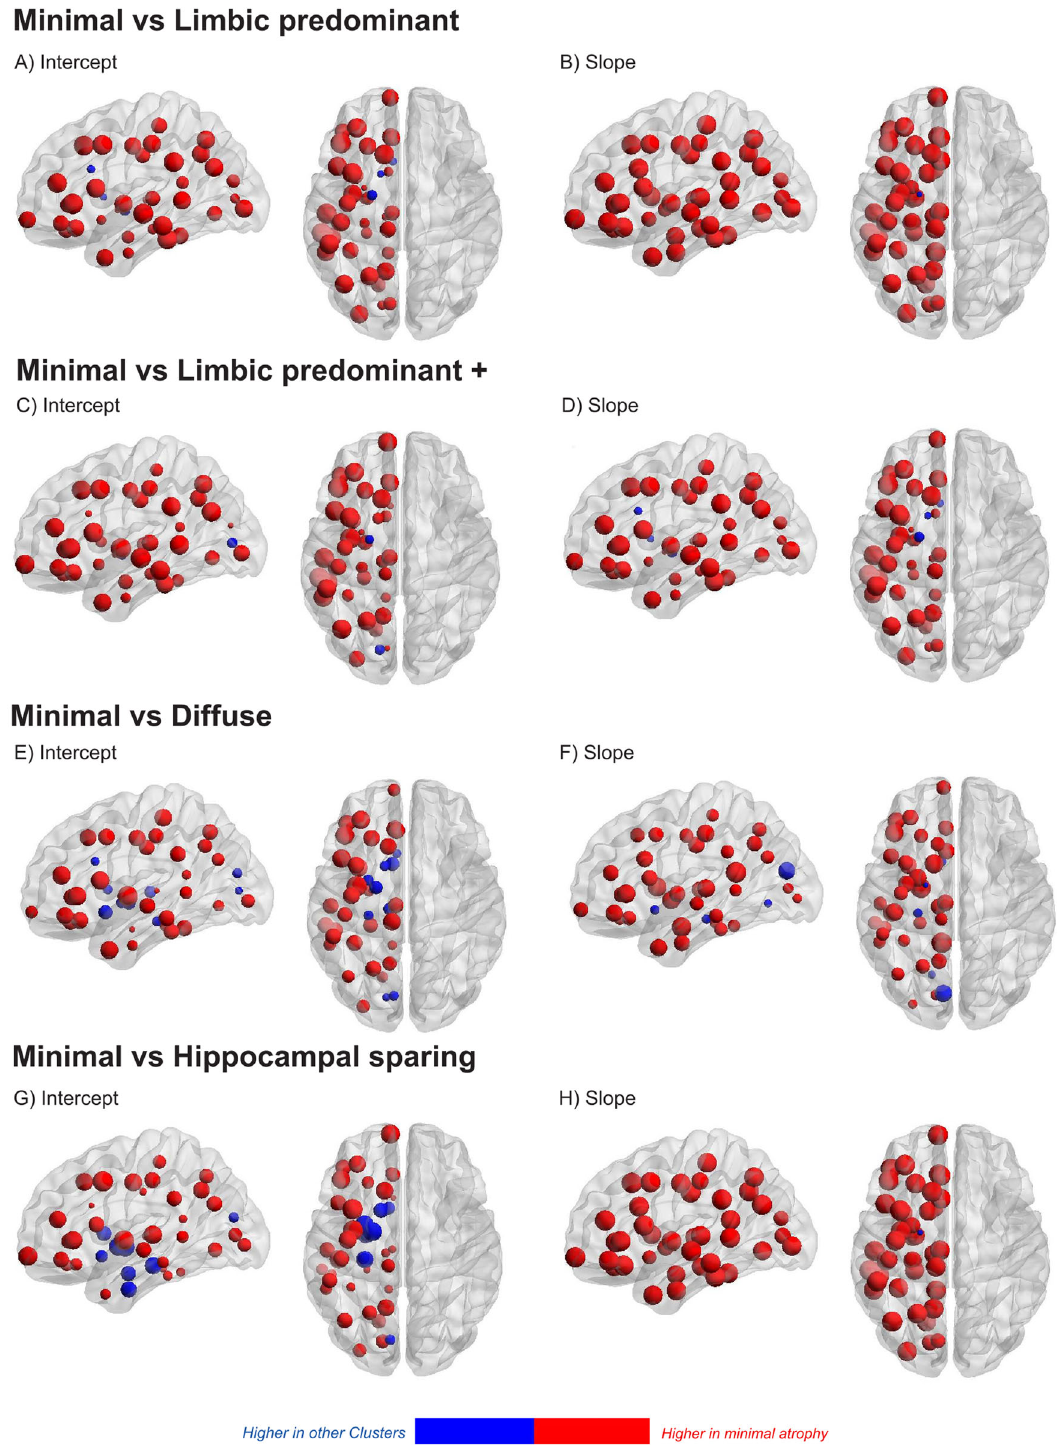
Fig.5|Comparisonofcluster-speci fi ccovariancematrixeswithnodestrength. The cluster-speci fi c intercept( A , C , E , and G ) and slope ( B , D , F , and H ) covariance matrices were compared with network theory. Sphere diameter shows the node